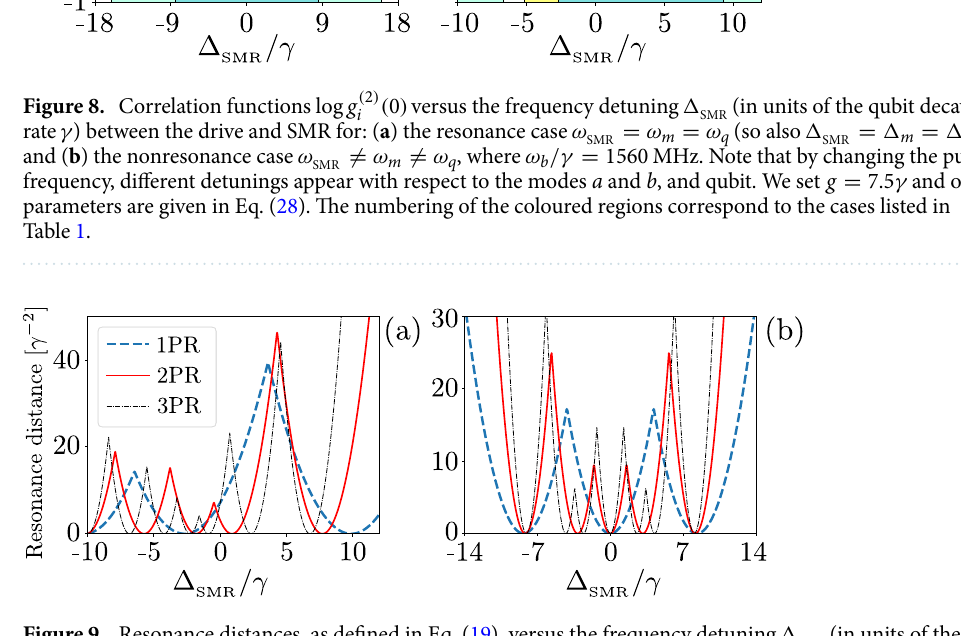
(in units of the qubit SMR 4.5 γ =